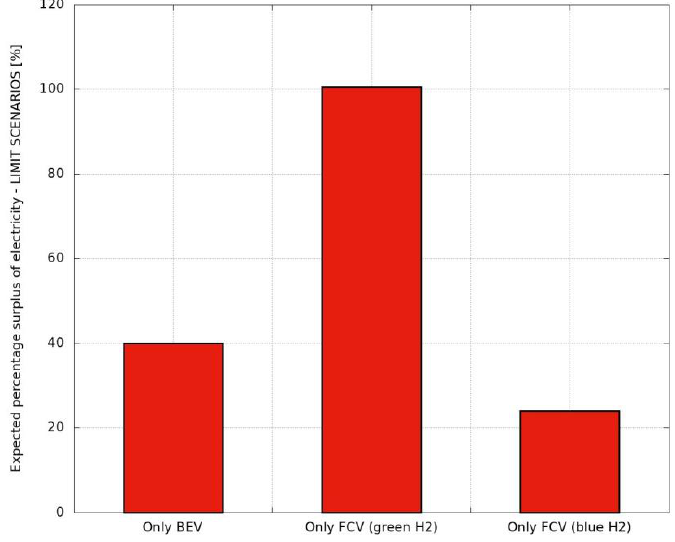
Figure 14. Expected electric energy production values per year in Italy in 2050 — LIMIT SCENARIOS.